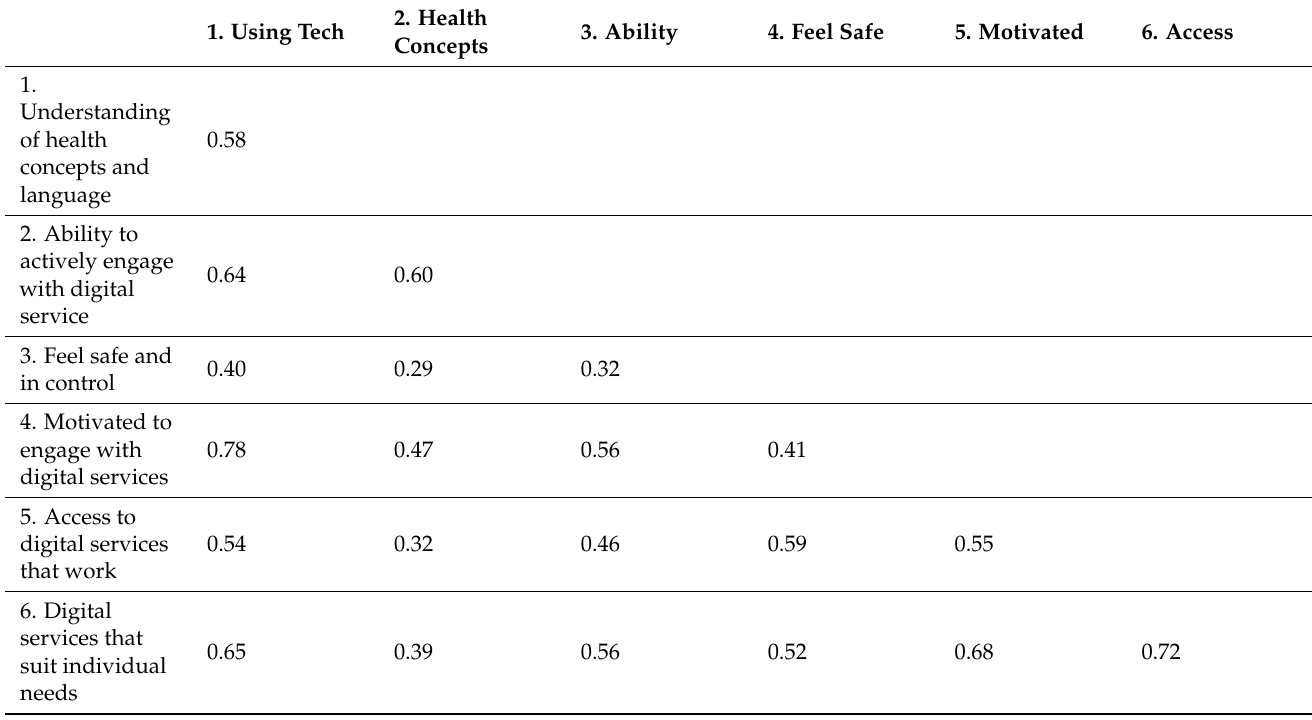
Table A2. Pairwise comparison tests among groups for age, education and use of digital platform and individual eHealth Literacy Questionnaire (eHLQ) scales.